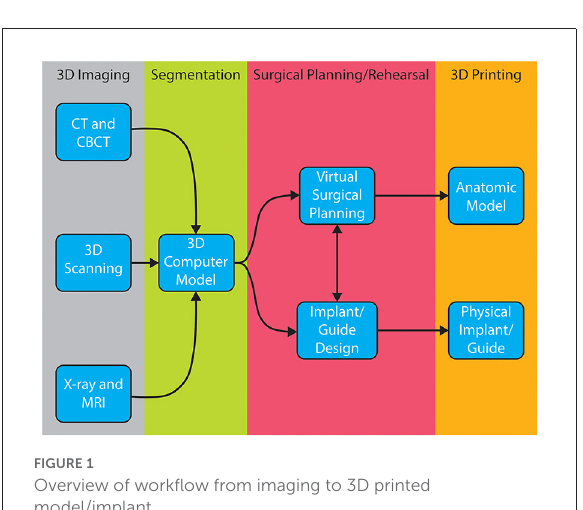
FIGURE1 Overview of workflow from imaging to 3D printed